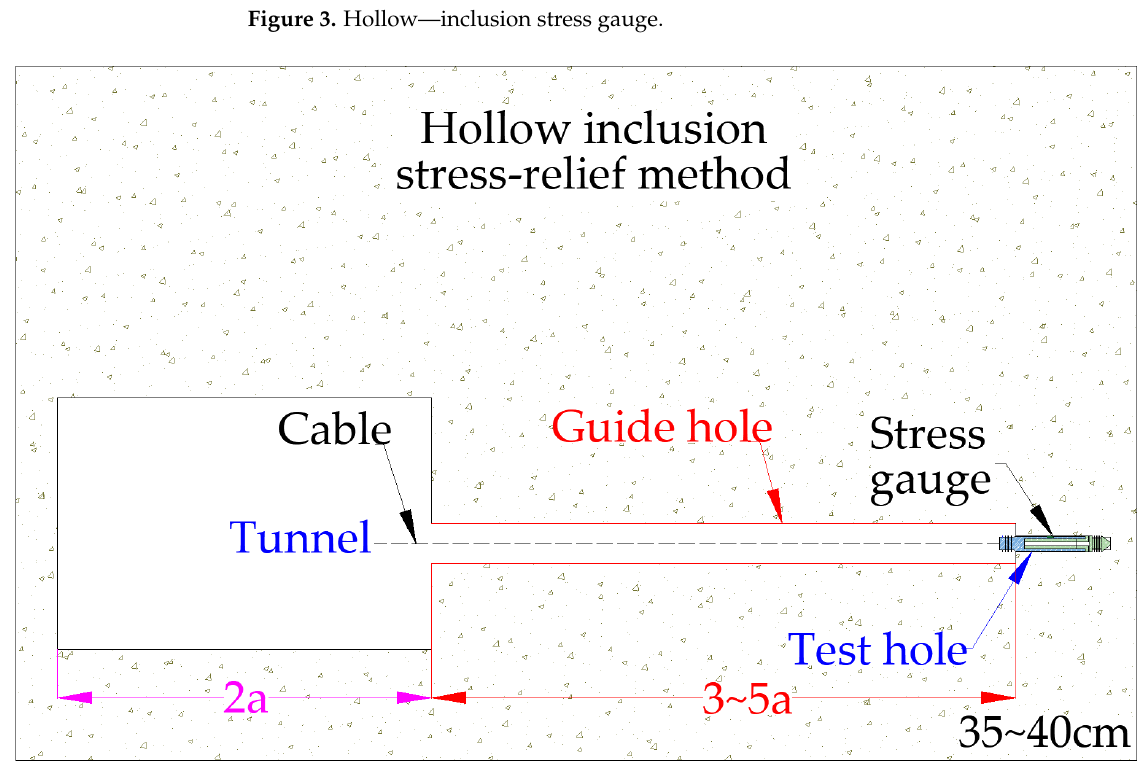
Figure 4. Test of the stress-relief method.